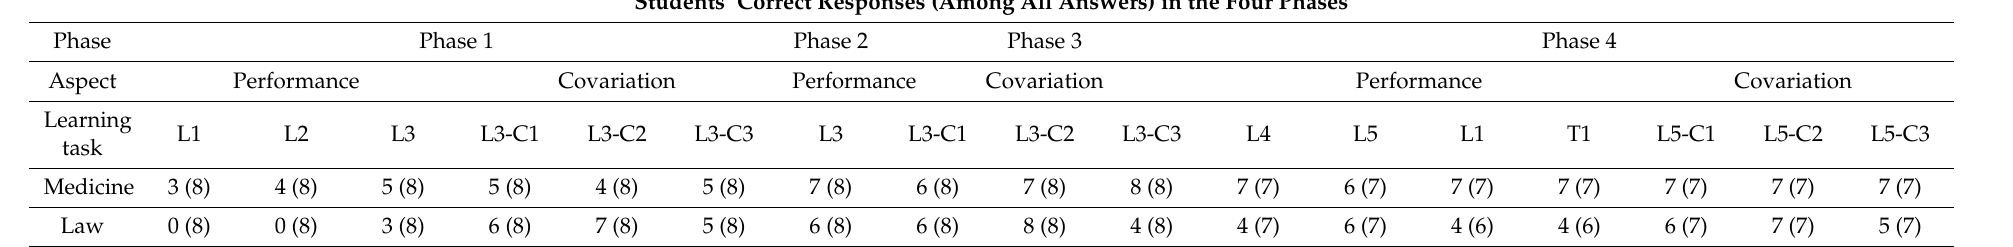
Table 2. Number of correct responses in the four phases of the formative evaluation (number of all students who worked on the task is given in brackets). L1–L5 refer to the 5 different learning tasks that were used here (compare Section 3.1). T1 refers to a learning task that was about a topic outside of one’s own domain (e.g., law context for students of medicine and medical context for students of law). Within the tasks on the aspect of covariation, C1 refers to changes in the false-positive rate, C2 to changes in the true-positive rate and C3 to changes in the base